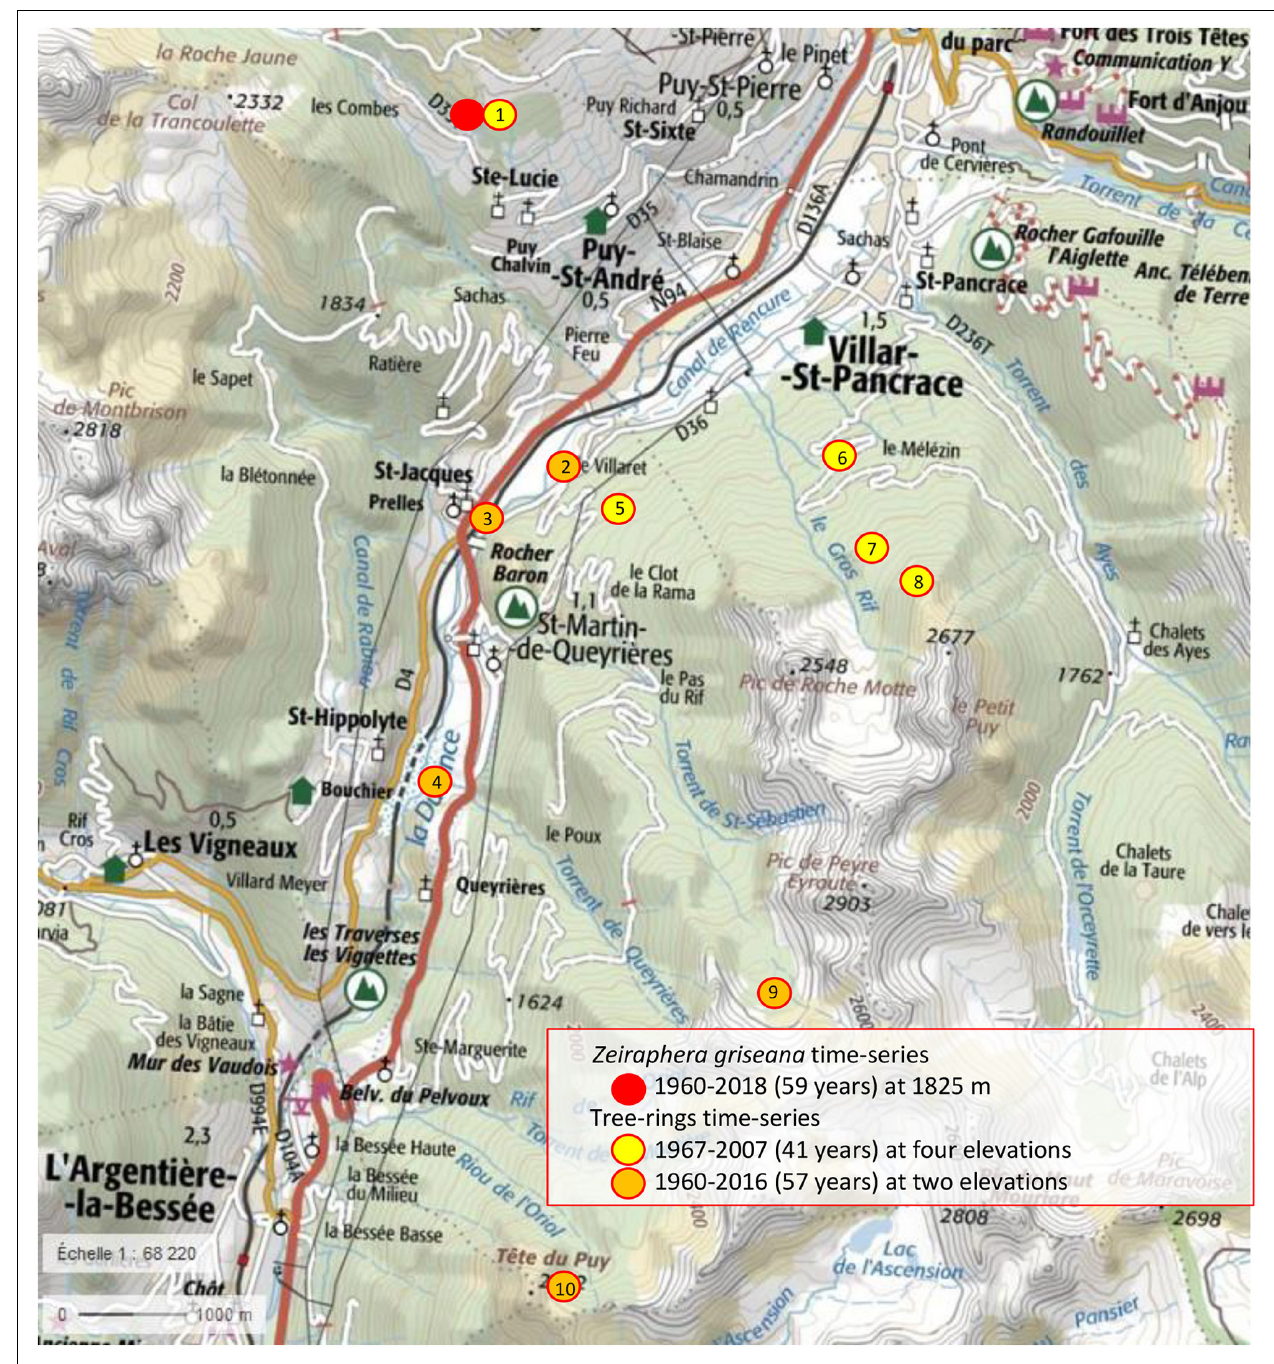
FIGURE 1 | Location of the plots (IGN map, France). The numbers in the bullets refer to the plots in Table 1 .